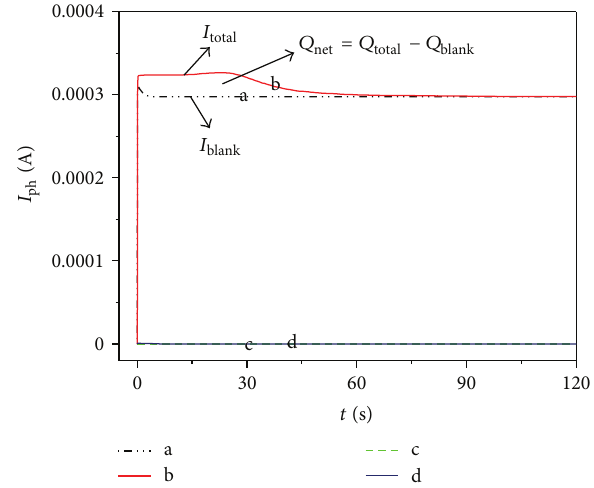
Figure 1: Typical photocurrent-time responses obtained from the thin-cell (a) 2.0 mol/L NaNO 3 solution under illumination; (b) 2.0 mol/L NaNO 3 with 0.4 mmol/L benzoic acid under illumination; (c) 2.0 mol/L NaNO 3 solution under no illumination; (d) 2.0 mol/L NaNO 3 with 0.4mmol/L benzoic acid under no illumination.